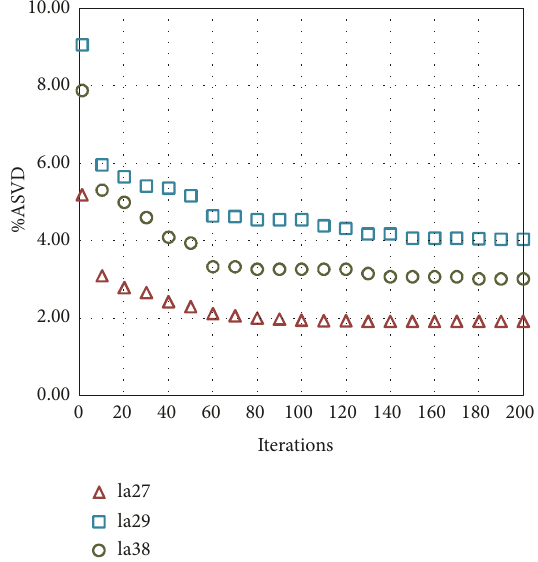
Figure 2: %ASVD-over-iteration plots of UPLA on la27, la29, and la38